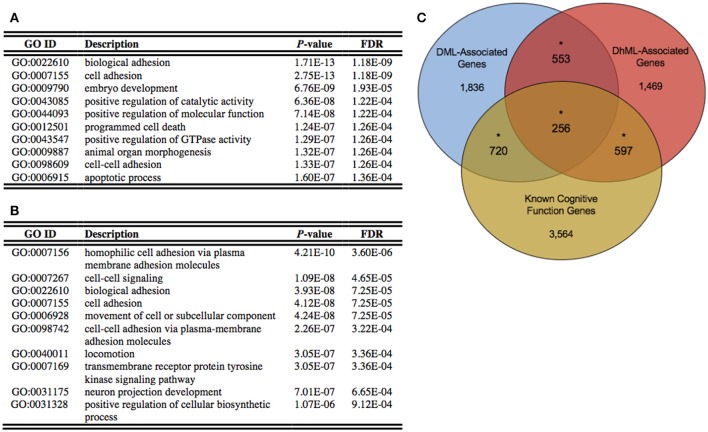
Differentially methylated and hydroxymethylated genes have neuronal functions. (A) Top ten gene ontological terms associated with all differentially methylated genes (B) Top ten gene ontological terms associated with all differentially hydroxymethylated genes (C) Venn diagram of the overlap of DML-associated genes (blue; N = 3,365), DhML-associated genes (red; N = 2,875) with genes known to function in intelligence, cognition, and learning and memory similarly tested within the gene universes (yellow; N = 5,137). The significant overlaps are indicated by an asterisk (Chi-square P < 0.05).